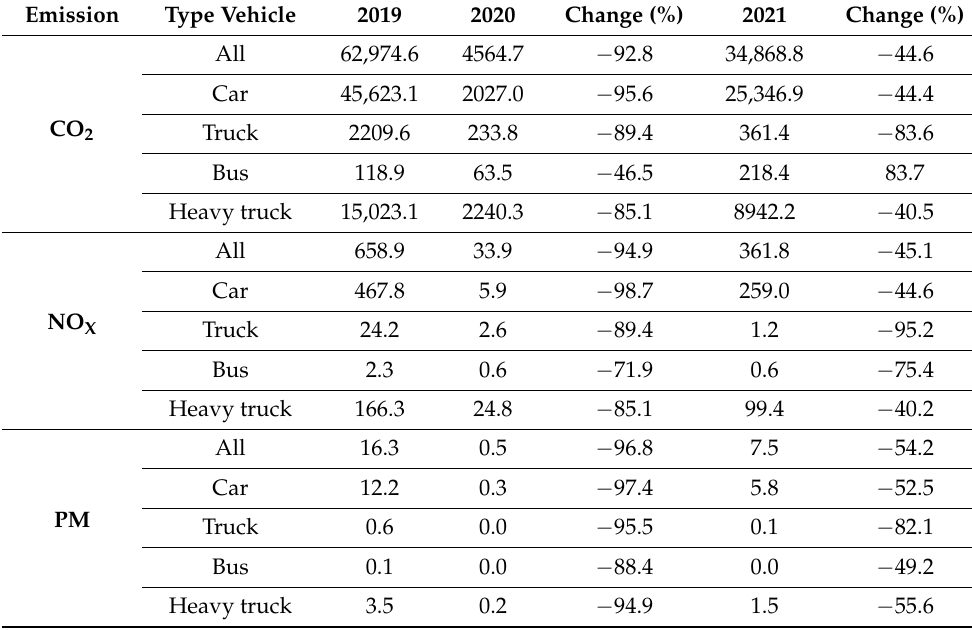
Table 4. Estimation of emissions produced by vehicles during the simulation.